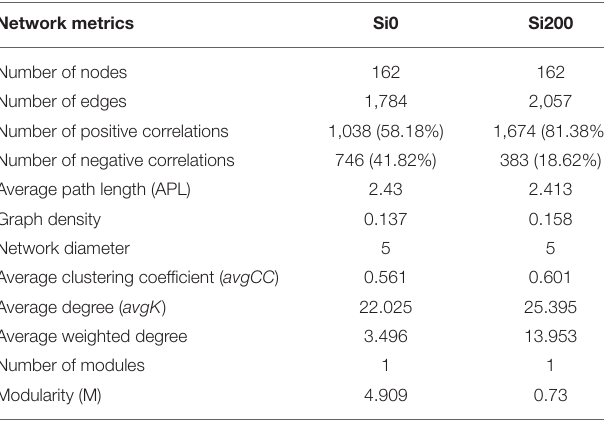
TABLE 4 | Topological properties of the bacterial networks obtained from the rhizospheres of the two silicon (Si) treatments. Network